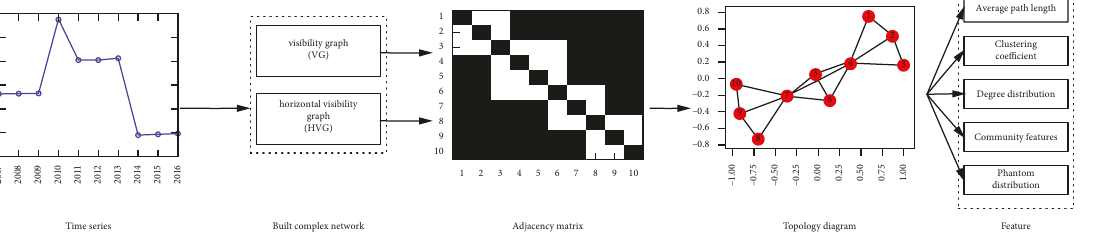
Figure 5: Network construction process from time series data.